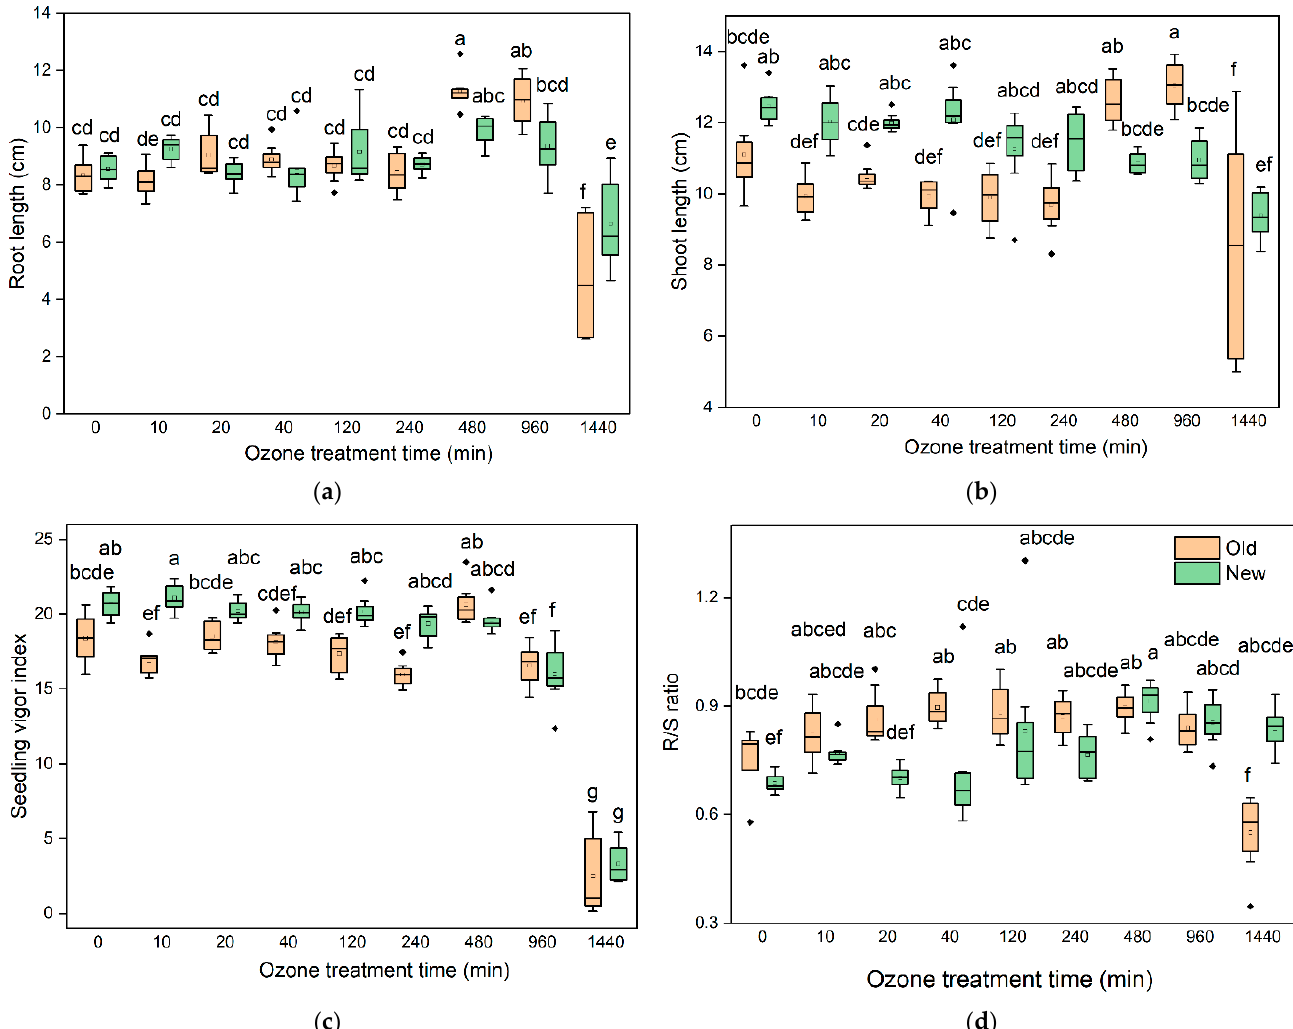
Figure 2. Changes in the morphological characteristics with O 3 treatment duration on ( a ) barley root length; ( b ) barley shoot length; ( c ) seedling vigour index of barley seeds; ( d ) the ratio of root-to-shoot length. Significant differences ( p < 0.05) between each treatment are indicated by letters. Groups do not have significant differences if they have identical marked letters. Statistical reliability of the differences was determined based on Tukey’s HSD test.